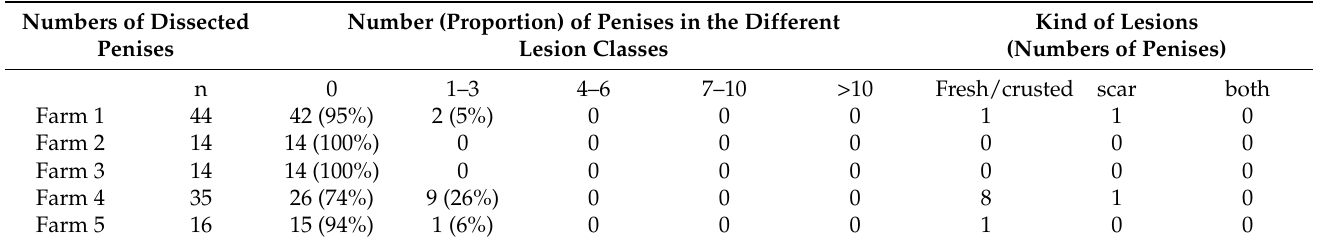
Table 7. Absolute and relative number of boars with penis lesions and the kind of lesions, n = 123 boars (scoring scheme: Isernhagen,